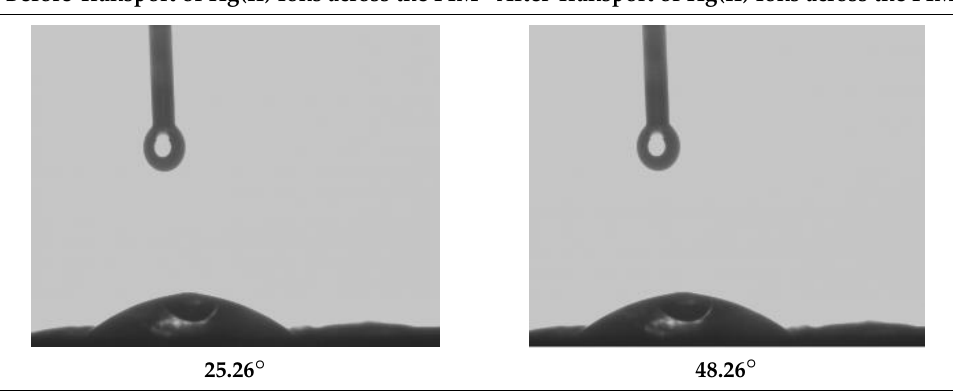
Before Transport of Hg(II) Ions across the PIM After Transport of Hg(II) Ions across the PIM